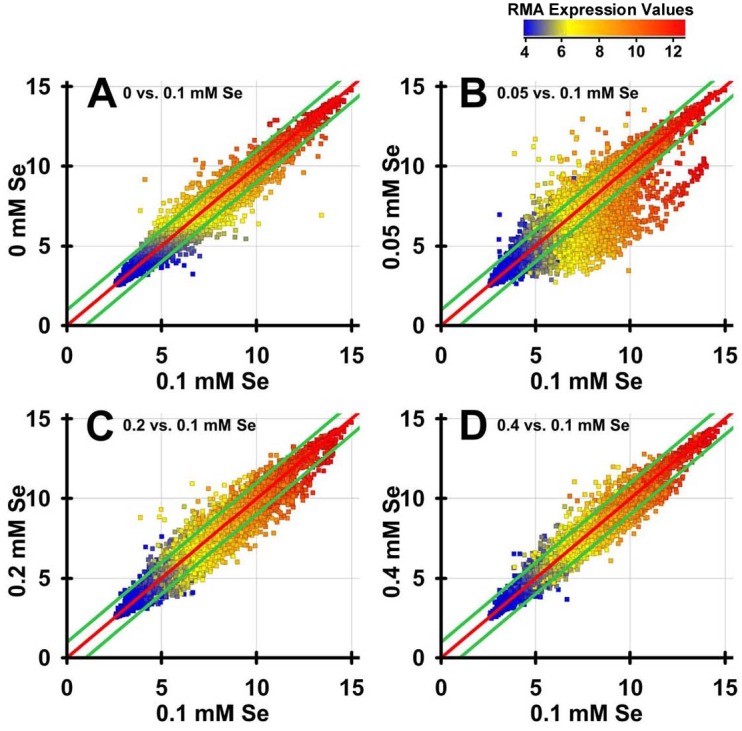
Effect of Se on the C. elegans transcriptome.Linear RMA expression values (non-normalized) from GeneSpring analysis of all 22,150 transcripts on the Affymetrix Whole Genome C. elegans GeneChip Array are plotted for 0 mM Se (A), 0.05 mM Se (B), 0.2 mM Se (C), and 0.4 mM Se (D) vs. expression values for 0.1 mM Se. Values on the x- and y-axis, and on the color legend, are the linear RMA expression data. The middle red line represents 1:1 expression, and the top and bottom green lines represent 2-fold up- and down-regulated expression, respectively. Each colored dot represents an individual transcript, with blue being a low abundance transcript and red being a high abundance transcript.